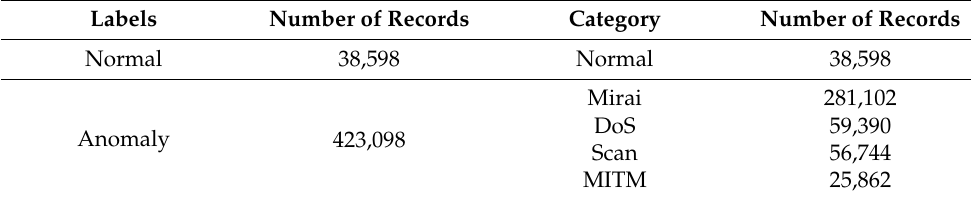
Table 2. IoTID20 dataset